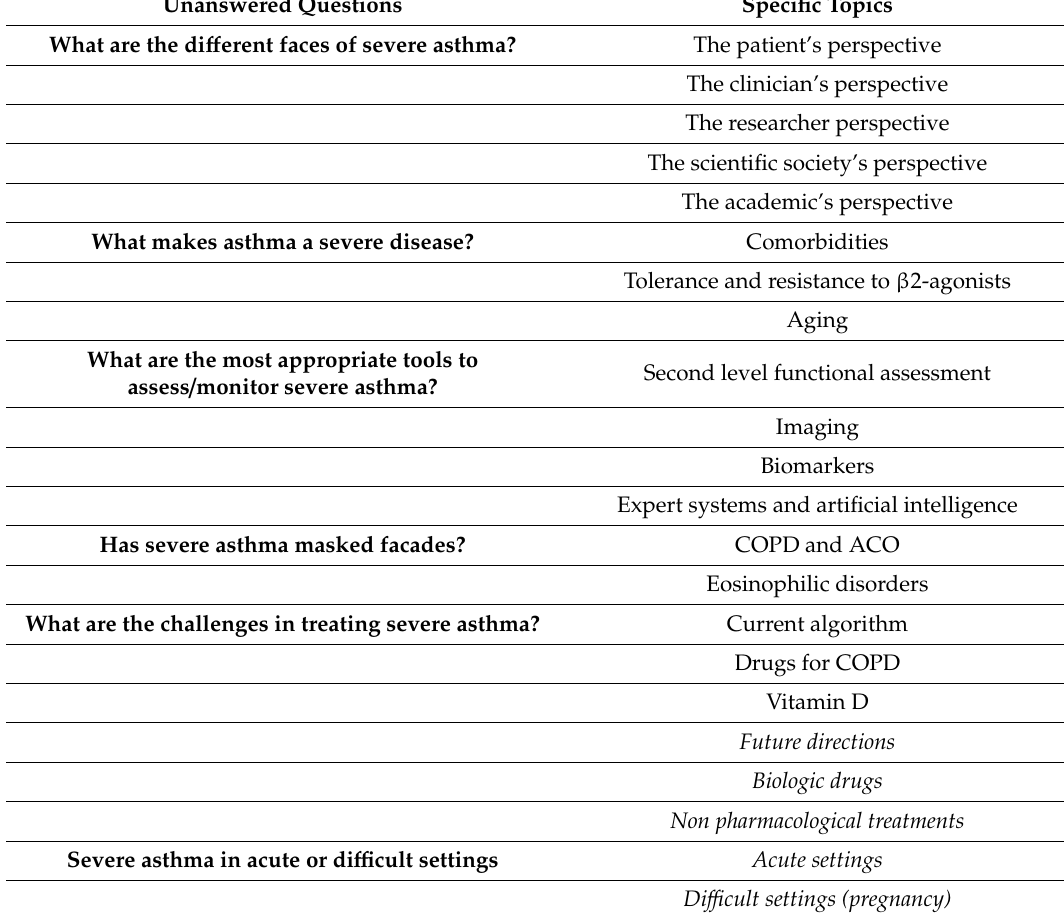
Table 1. Lists of topics identified from the Delphi